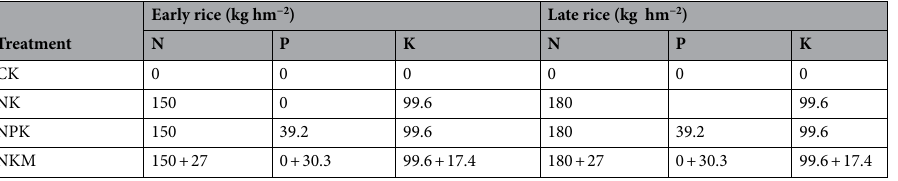
Table 5. Descriptions of N, P, K applications of early and late rice under different fertilization treatments. In the NKM treatment, the first and the second value are the amount of NPK applied as chemical fertilizer and as pig manure, respectively. CK: unfertilized control; NK: mineral fertilizer NK; NPK: mineral fertilizer NPK; NKM: mineral fertilizer NK combined with pig